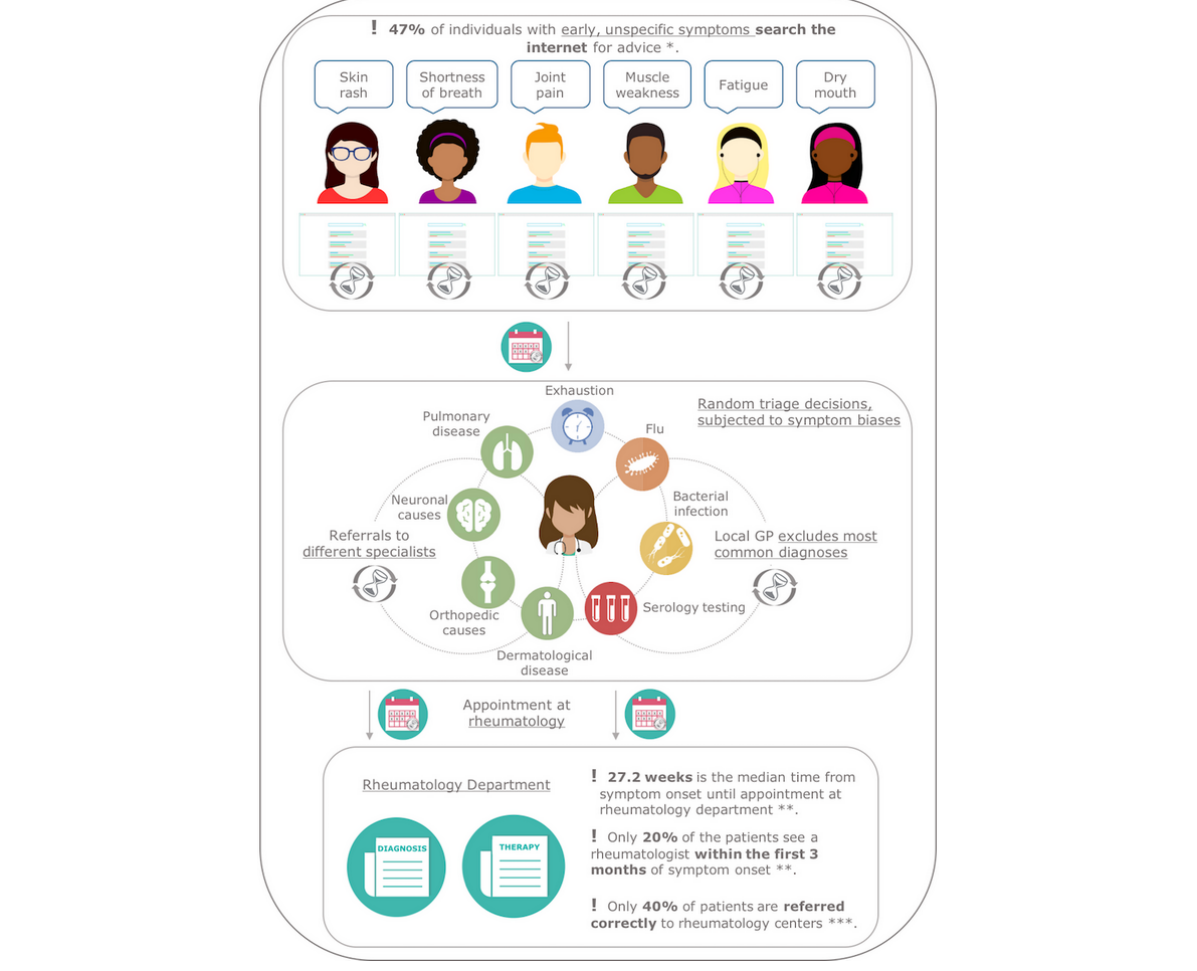
Figure 1. Diagnostic delay and inefficient health care service. GP: general practitioner. *Powley et al [21]. **Stack et al [10]. ***Feuchtenberger et al